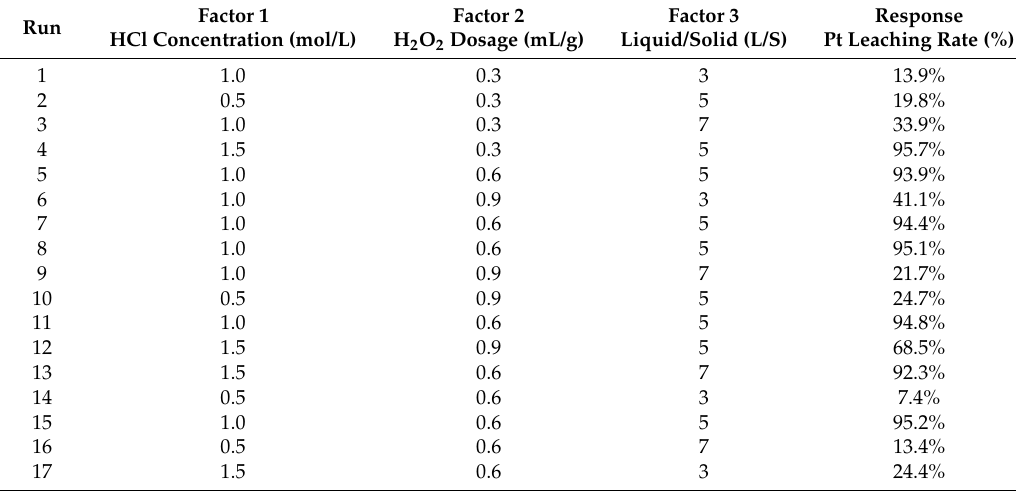
Table 5. Factors and response values of Pt